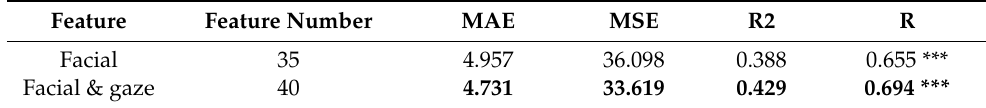
Table 3. Performance comparison of different characteristics.